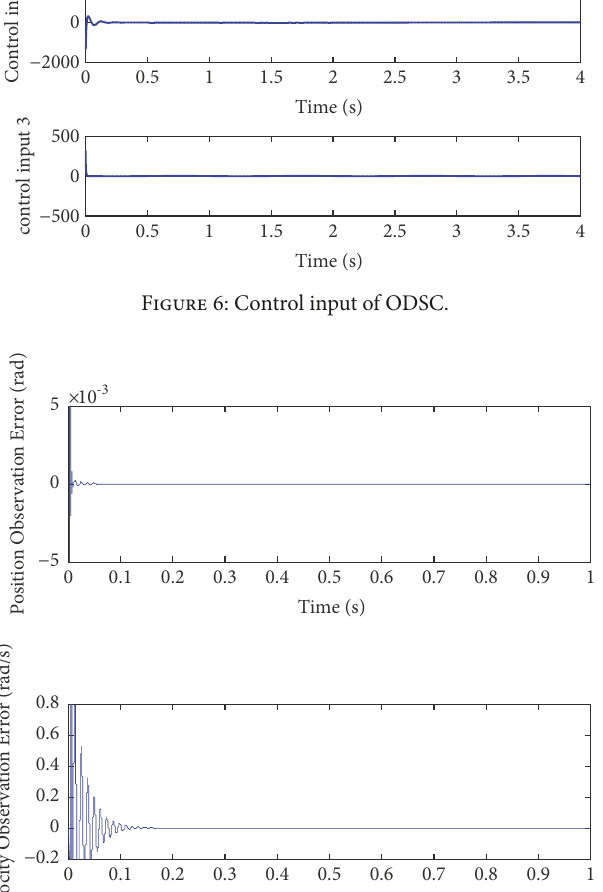
Figure 7: The estimation error of position and velocity of